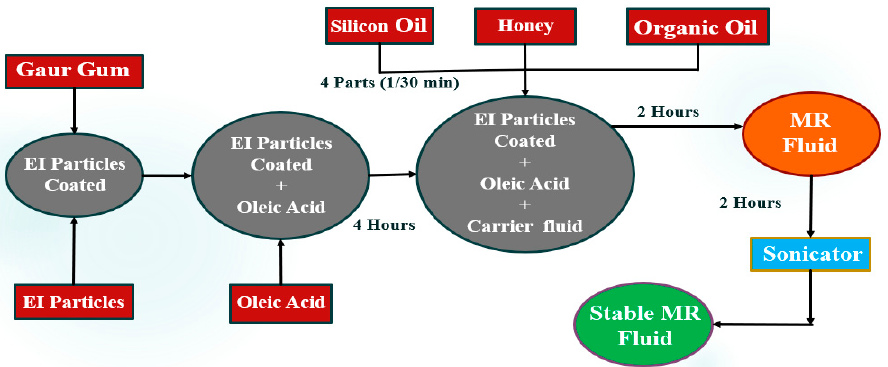
Figure 1. The manufacturing process of magnetorheological (MR) fluids featuring various liquid oils.